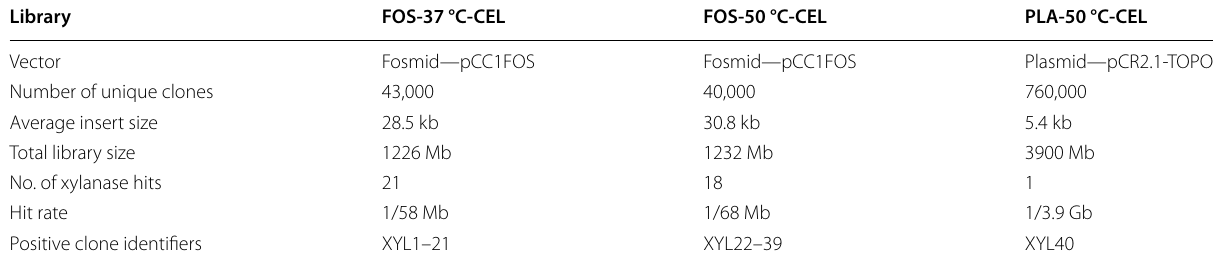
Table 1 Details regarding the metagenomic fosmid and plasmid libraries constructed and screened for xylanase activity